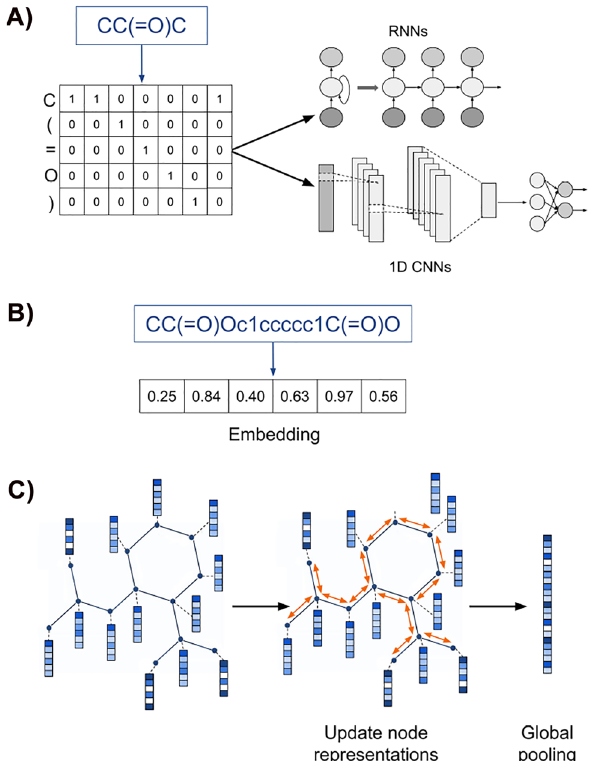
Figure 2: Learned representations of compounds. (A) Representations can be learned directly from SMILES strings using DL architectures such as RNNs or 1D CNNs. (B)Naturallanguageprocessing-inspiredmethodscanbe used to generate continuous embeddings of molecules. (C) GNNs can be used to learn representations directly from molecular